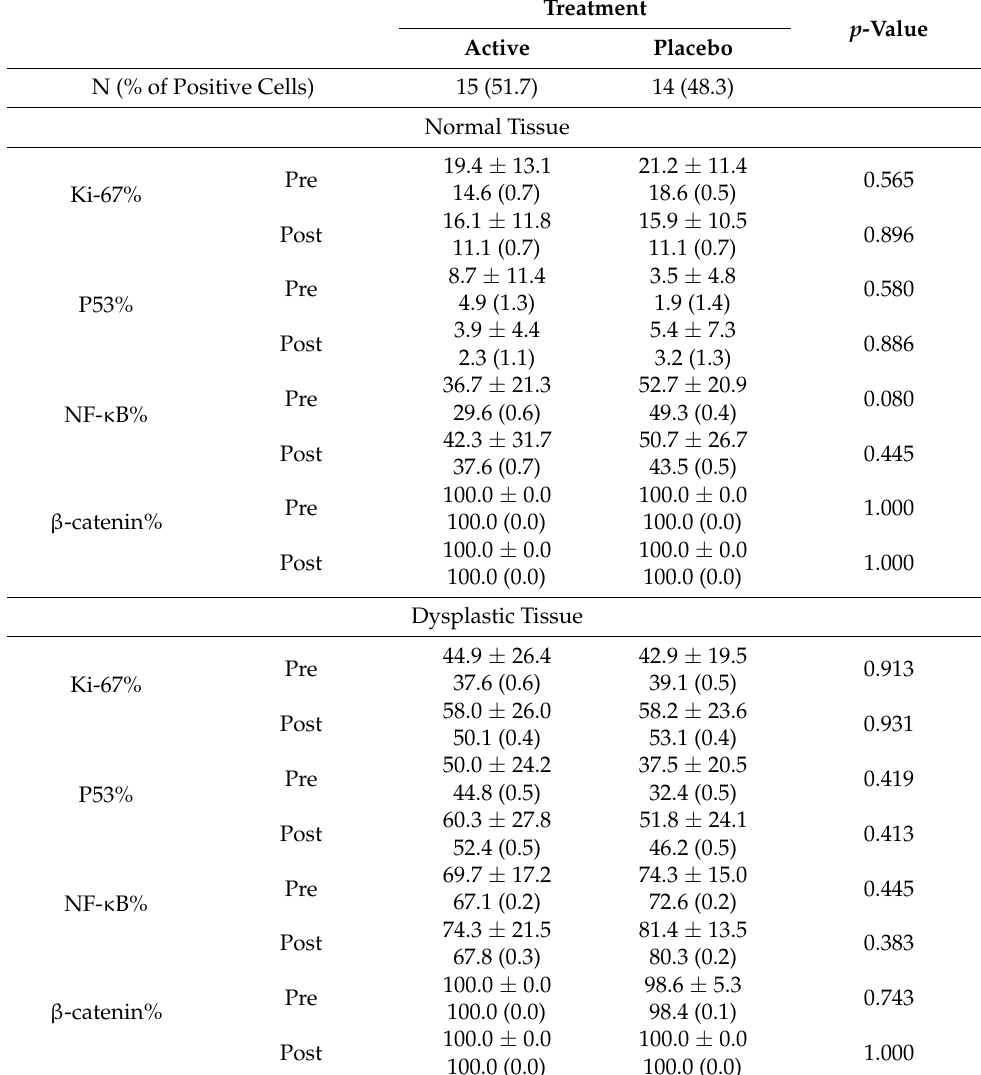
Table 2. Tissue biomarker expression according to the treatment arms and the time points in normal and dysplastic